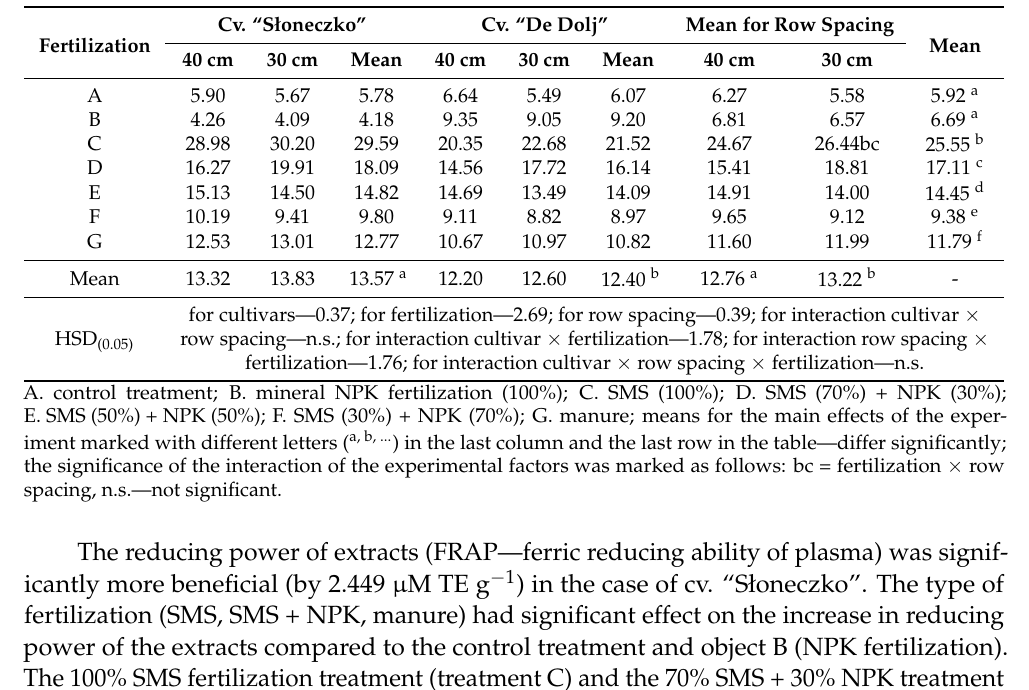
Table 8. ORAC (oxygen radical absorbance capacity) antioxidant activity determined in thyme raw material ( µ M TE g − 1 ).